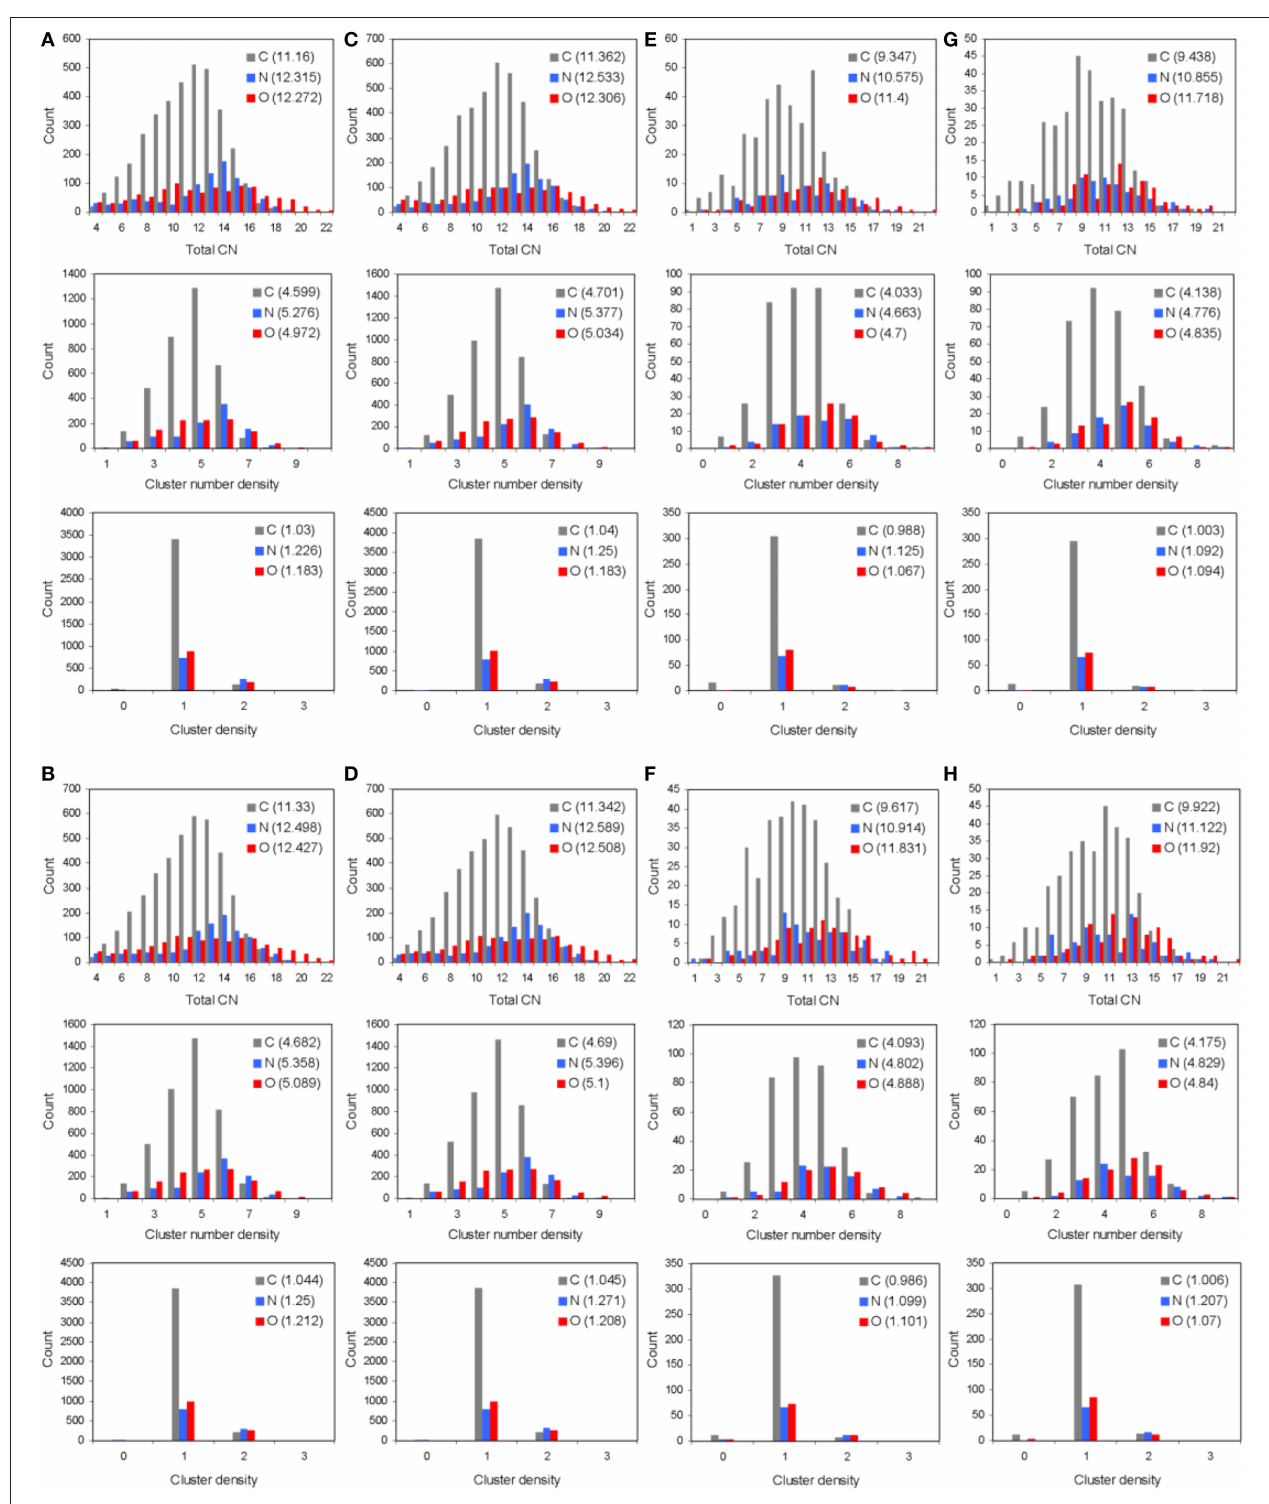
FIGURE 3 | Short range order statistics (total coordination number, CN, number density, and density, up to interatomic distances of 4Å) for unprotonated pMHC-TCR complexes of (A) Tax, (B) V7R, (C) Y8A, and (D) P6A. Also, short range order statistics for unprotonated complex environments including atoms up to a distance of 7Å from peptide atoms: (E) Tax, (F) V7R, (G) Y8A, and (H) P6A. Statistics are shown for the C, N, and O species as differently colored bars. Weighted averages for each atom are shown in parentheses and are defined as ( 6 x i N i )/ 6 N i , where x i is the ith PDF bin and N i is the histogram value.